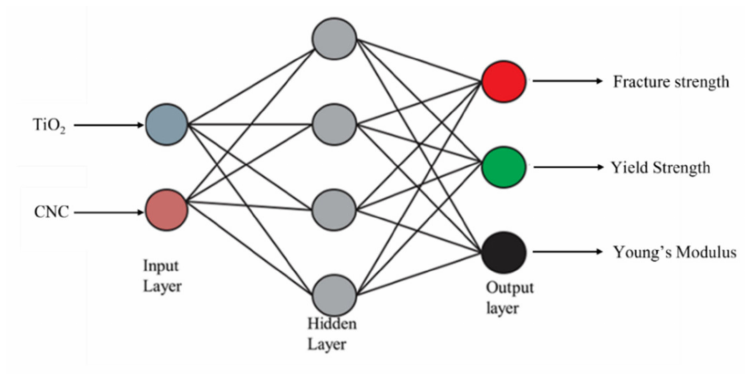
Figure 4. The neural network architecture used in this